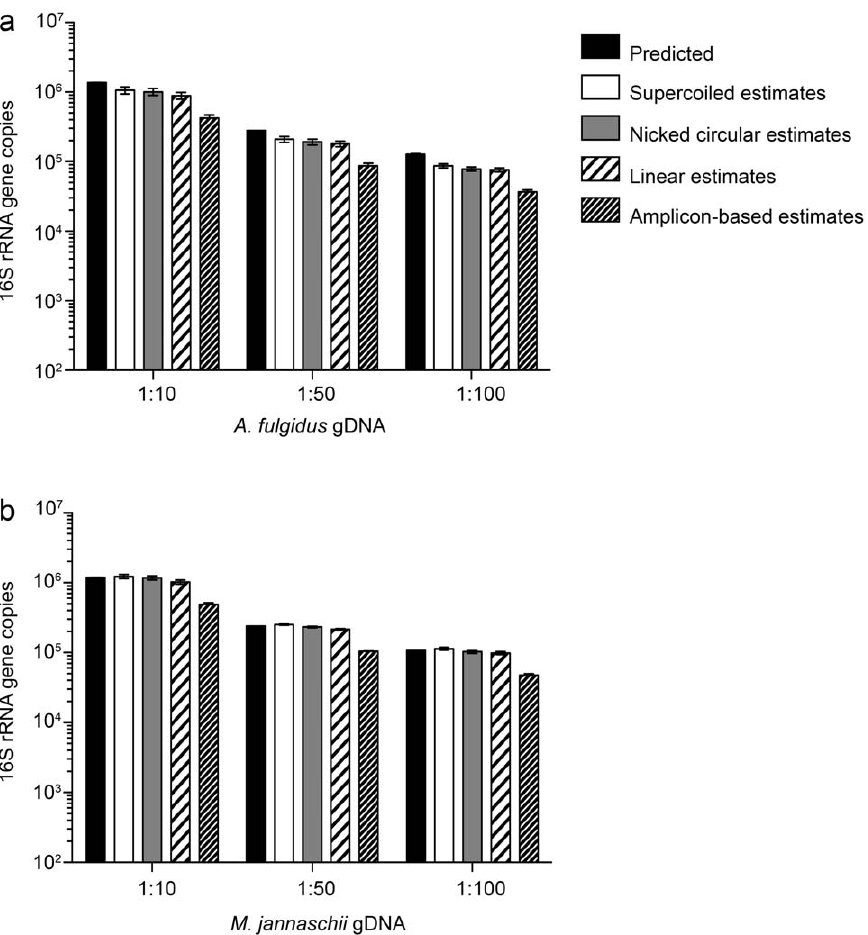
Figure 4. Comparison of expected and estimated 16S rRNA gene copies in archaeal DNA samples. Expected archaeal 16S rRNA gene copies were calculated based on one and two 16S copies per genome for ( a ) A. fulgidus and ( b ) M. jannaschii , respectively. Black bars=predicted 16S copies. White bars=estimated 16S copies based on supercoiled plasmid standard. Grey bars=estimated 16S copies based on nicked circular plasmid standard. Black and white striped bars=estimated 16S copies based on linearized plasmid standard. Black and gray striped bars=estimated 16S copies based on amplicon standard. Data shown are representative of two experiments. Data are the average (n=3) and error bars are 6 1 standard deviation among